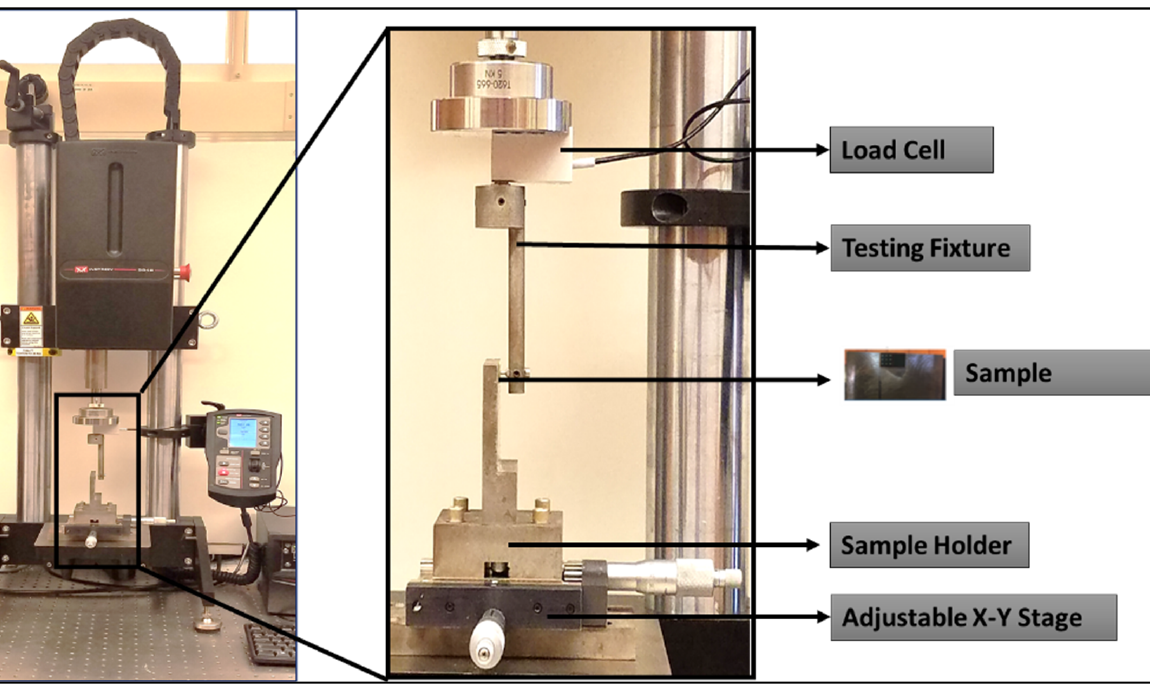
Figure 2. Instron 5948 testing machine.